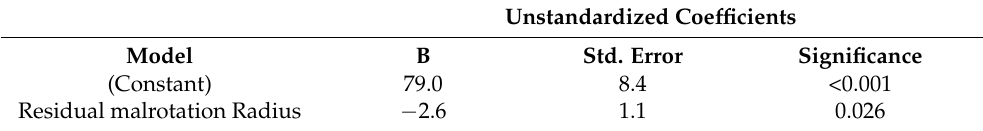
Table 3. Multi-variate linear